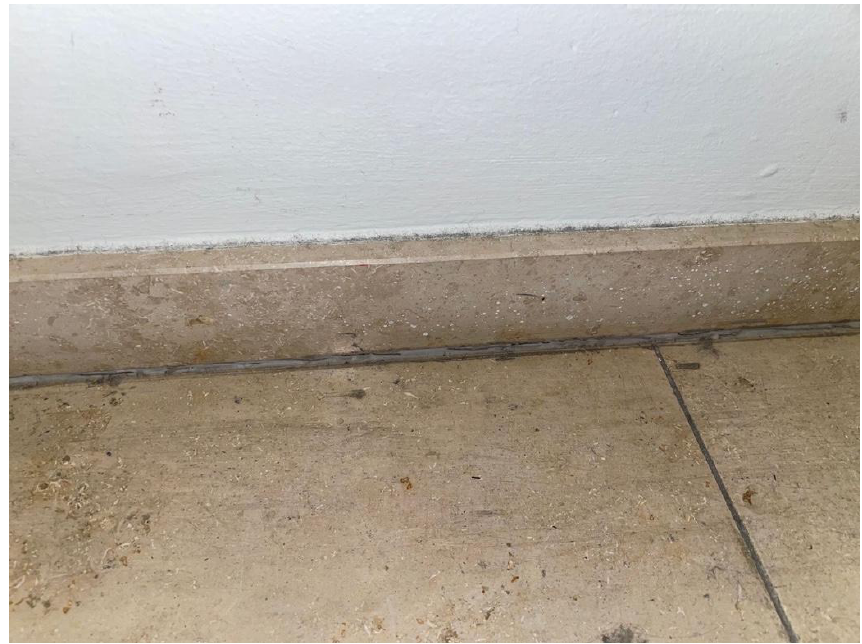
Figure 8. Microhabitat 1 of Ctenolepisma calvum in the Firebrigade museum in Vienna with a stone floor.